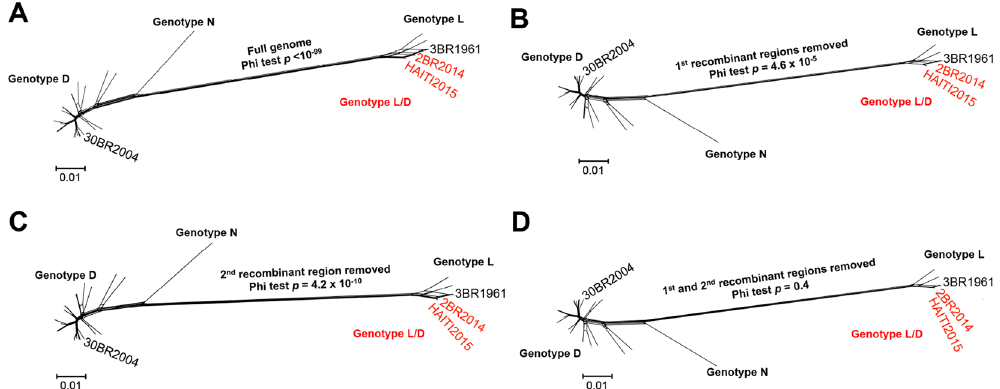
Figure 2. Detection of recombination in the MAYV genome using split-decomposition based networks. Network graphs were generated in SplitsTree based on the ( A ) full genome sequence, ( B ) genome sequence with recombinant regions as a result of the first recombination event removed, ( C ) genome sequence with recombinant region of the second recombination event removed, and ( D ) genome sequence with recombinant regions as a result of the first and second recombination events removed. The p -values of the Phi test of recombination for each genomic fragment are reported in each